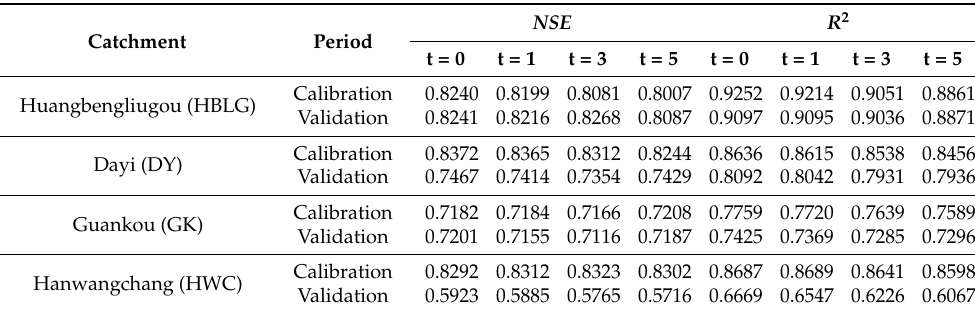
Table 8. The values of Nash–Sutcliffe Efficiency Coefficient ( NSE ) and Correlation Coefficient ( R 2 ) during calibration and validation periods (t = 0, 1, 3, and 5). NSE R Catchment Period